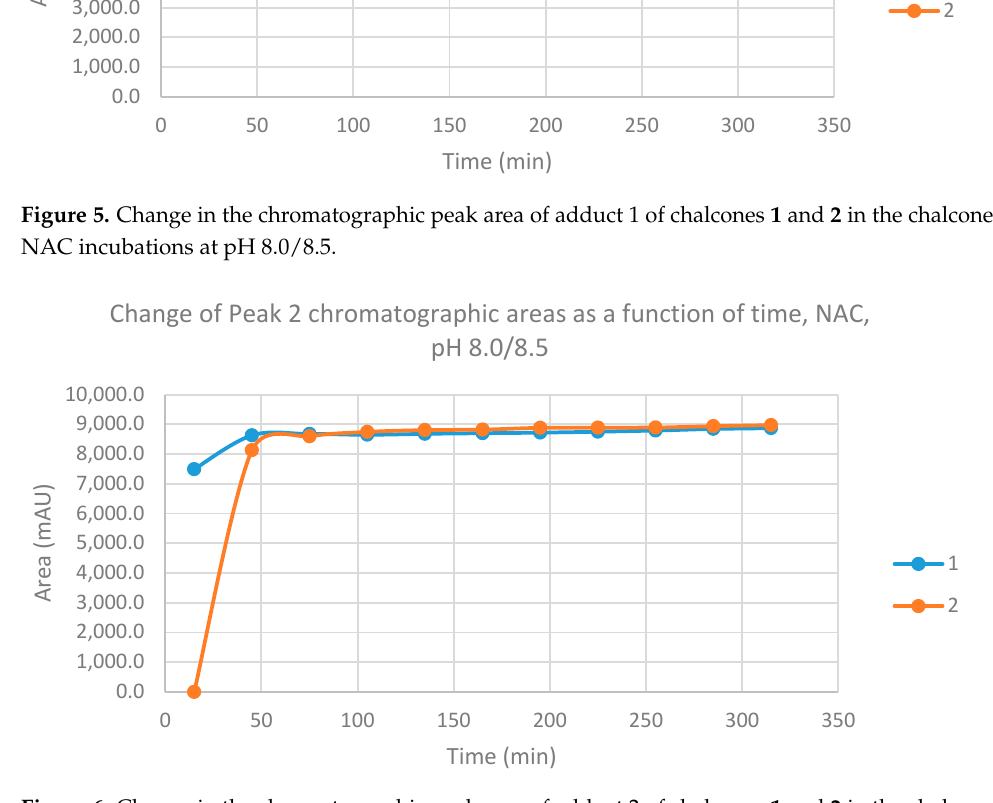
Figure 6. Change in the chromatographic peak area of adduct 2 of chalcones 1 and 2 in the chalcone– NAC incubations at pH 8.0/8.5.